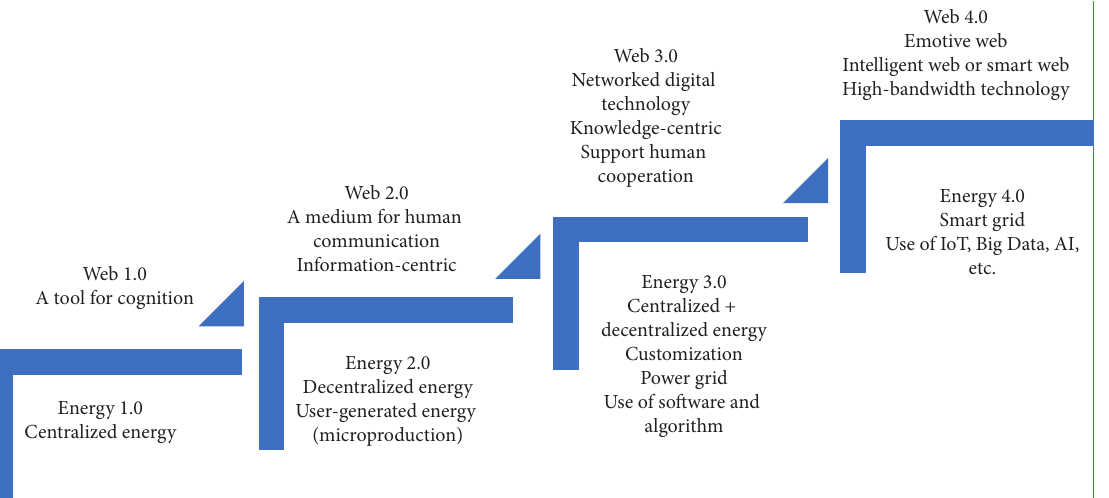
Figure 3: The transition in web and energy systems.